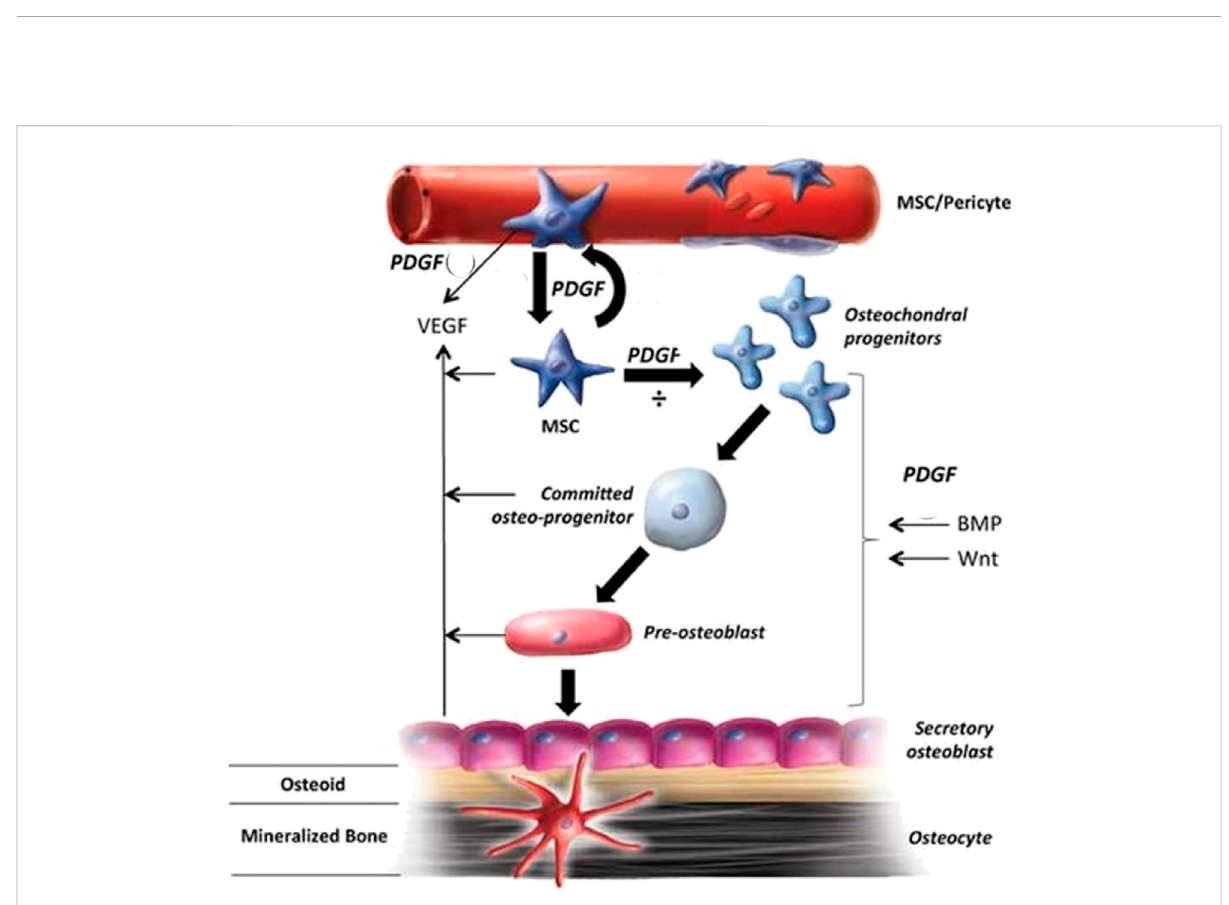
FIGURE 5 The role of PDGF in bone healing and the mechanisms involved (Reproduced with permission from Ref (Caplan and Correa, 2011). Copyright © 2011 Orthopaedic Research Society).